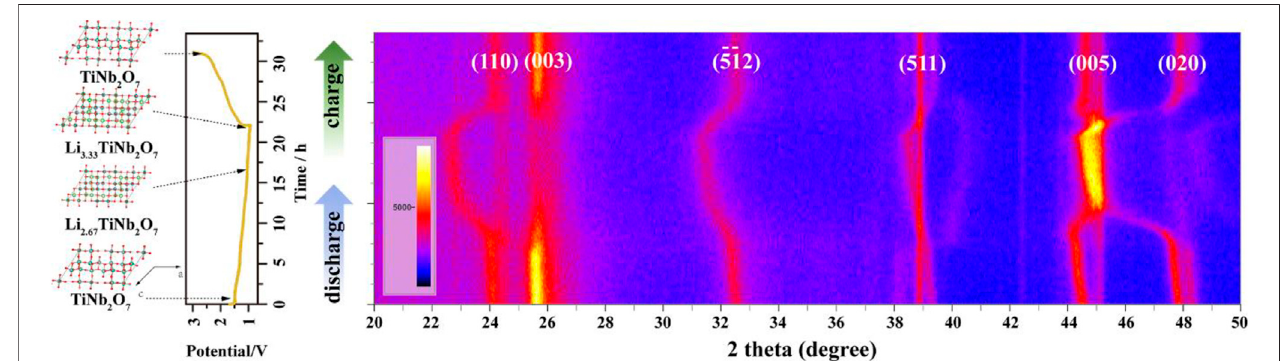
FIGURE 7 | In situ XRD patterns of TNO/NC/GO in the 2 θ range of 20 – 50 ° .